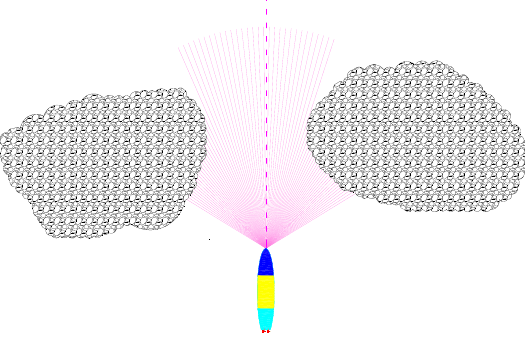
Figure 6. FLS detecting data grouped.